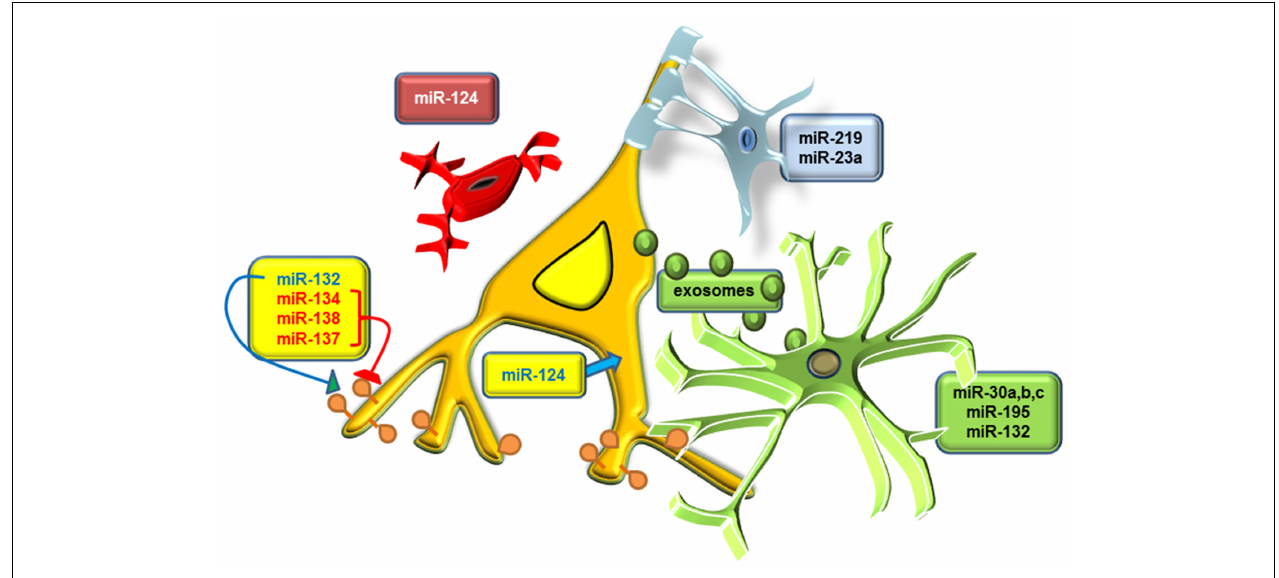
miR-195 and miR-30a, miR-30b, and miR-30c. Secretion of microvesicles that are known to contain miRNAs (exosomes) by astrocytes is also depicted. Expression of miR-124 is shown in both neurons, where it promotes neurite outgrowth, and microglia (shown in red), where it suppresses their activation. Oligodendrocytes (shown in light blue) express high levels of miR-219 and miR-23a, which regulate their